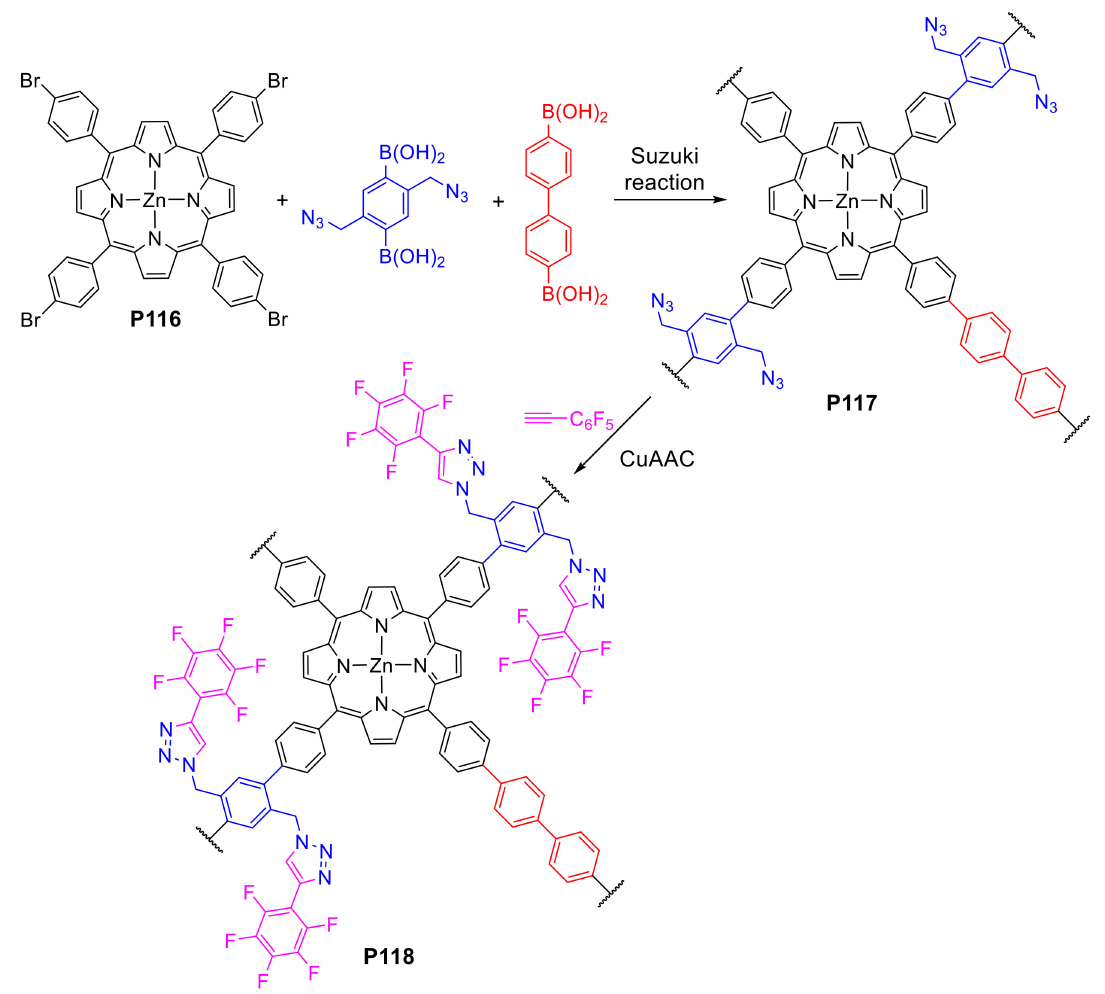
Drašar and co-workers reported the synthesis of the two trilobolide-porphyrin conjugates P119 and P120 (Figure 10) [80]. Trilobolide is a natural sesquiterpene lactone isolated from horse caraway (Laser trilobum, L. Borkh) that exerts significant pharmacological properties. The trilobolide unit was linked to porphyrin derivatives via CuAAC reactions and the in vitro cytotoxicity of the resulting conjugates was tested against rat peritoneal cells and four human tumor cell lines: LNCaP (prostate